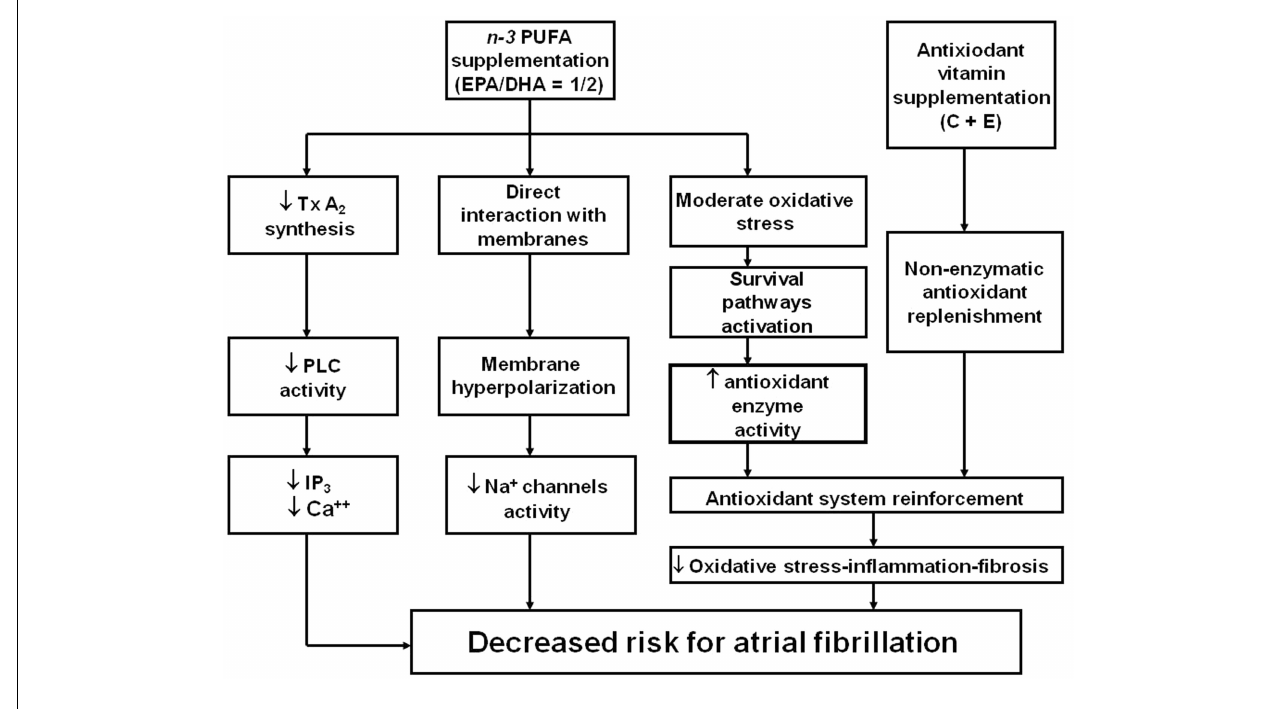
eicosapentaenoic acid; DHA, docosahexaenoic acid; PLC, Phospholipase C;Tx A 2 ,Thromboxane A2; IP 3 , Inositol trisphosphate; Ca ++ , cytosolic calcium. Adapted from Rodrigo et al. (2008) with